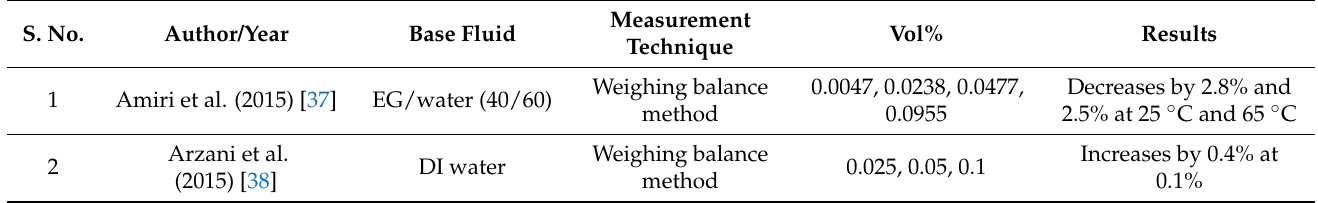
Table 8. Summary of published literature on density of graphene-based